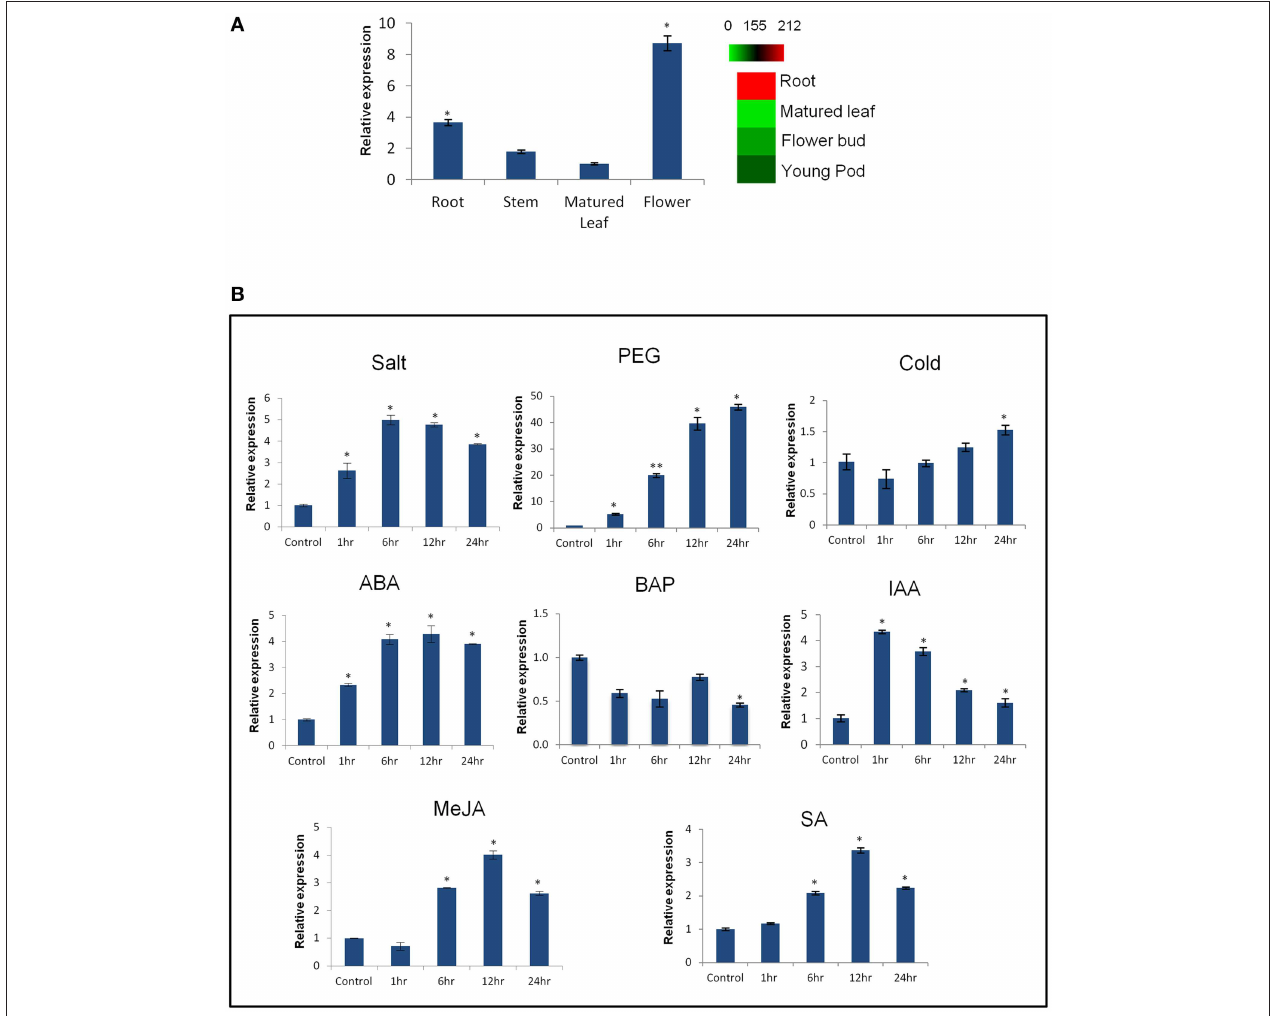
FIGURE 2 | Expression analysis of CaCIPK25 gene in different tissues and under different treatments. (A) Fold expression of CaCIPK25 gene, keeping its expression level in matured leaf as reference, in different tissues as assessed by qRT-PCR. Digital expression profile of the corresponding transcript using RNASeq data is shown by a heatmap. (B) Fold expression change of CaCIPK25 gene in whole chickpea seedlings upon treatment with various stresses and hormones as mentioned. Chickpea EF1 α gene was used as internal control. Values in the Y-axis describe fold-changes in expression. X-axis describes time periods. Standard deviations were derived from three biological replicates. * , ** indicate statistically significant difference ( p < 0 . 05 ) and ( p < 0 . 01 ), respectively, from the control